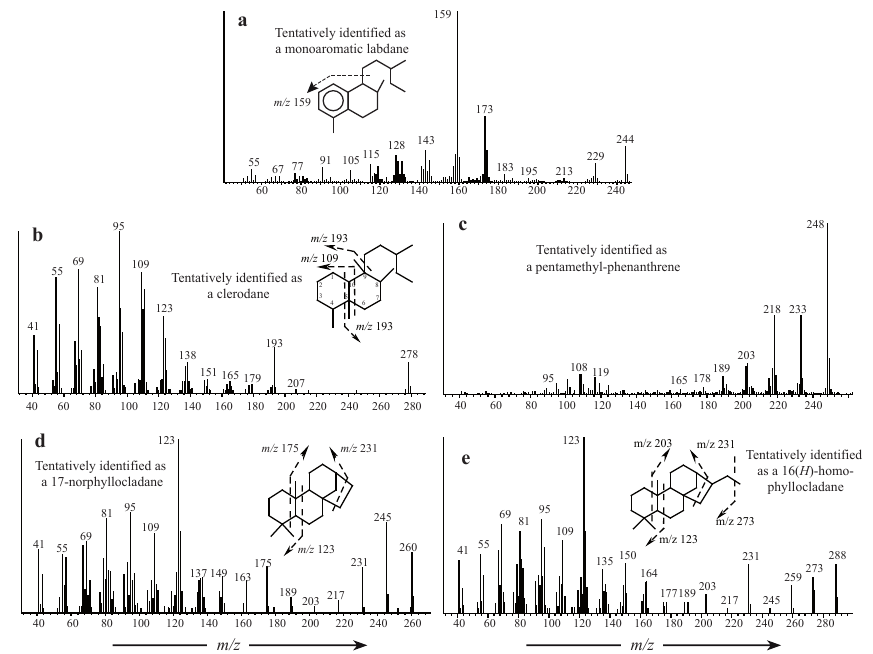
Fig. 8. Mass spectra of some tentatively identified Araucariaceae diterpenoids and suggested mass spectral cleavage patterns for (a) , (b) , (d) and (e) . (a) : monoaromatic labdane; (b) : clerodane; (c) : pentamethyl-phenanthrene; (d) : 17-norphyllocladane (identified according to